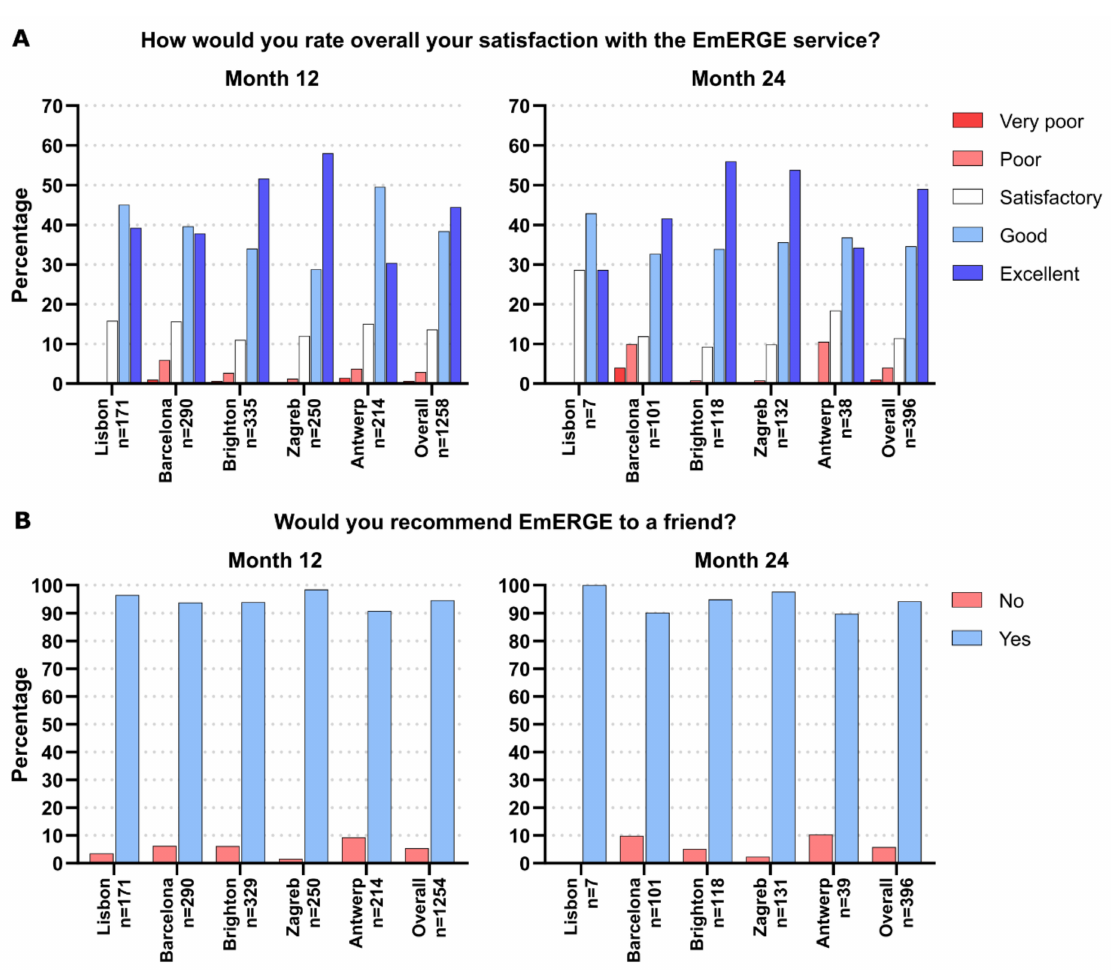
Figure 6. Distribution of the responses related to satisfaction with the EmERGE service at month 12 and month 24 across the